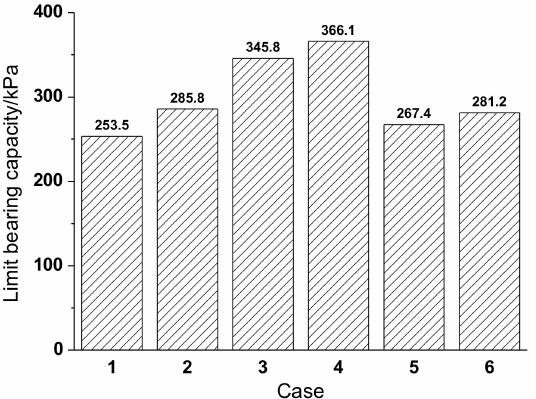
Figure 10. Experimental values of limit bearing capacity under different